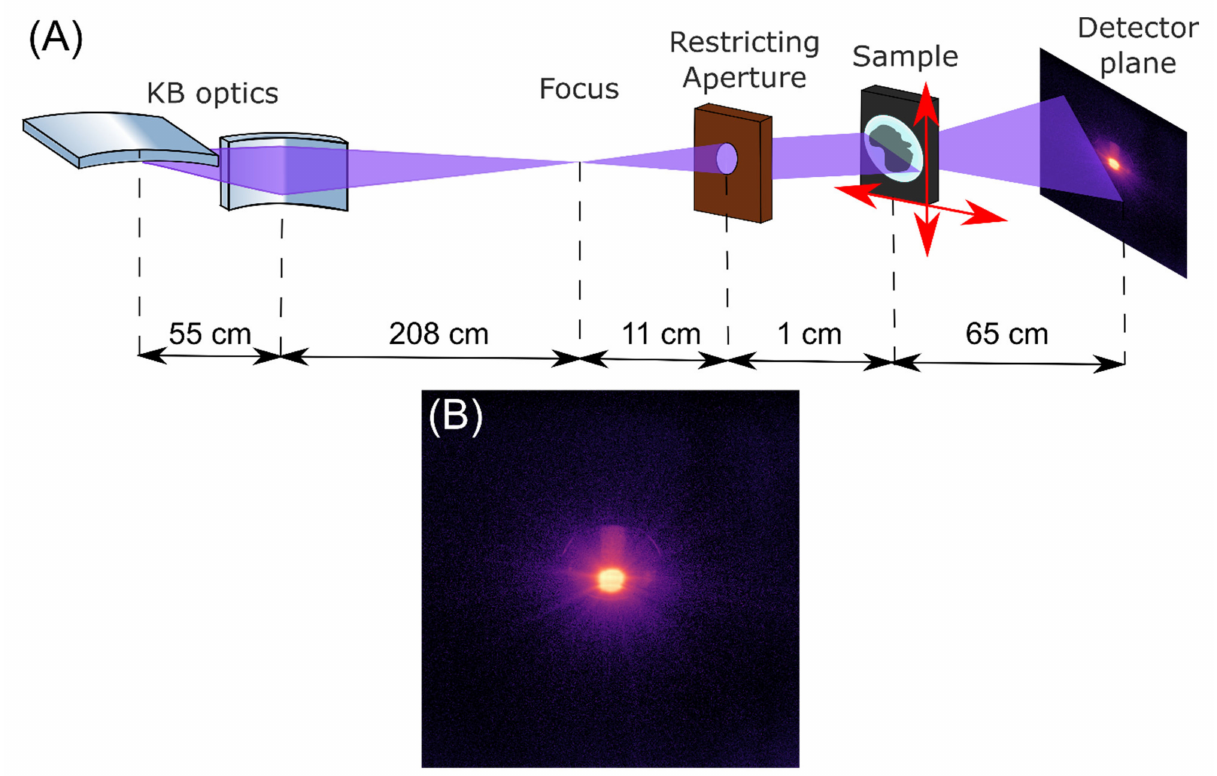
Figure 2. Ptychography experiment setup ( A ) and a typically measured diffraction (13 × 13 mm 2 ) pattern ( B